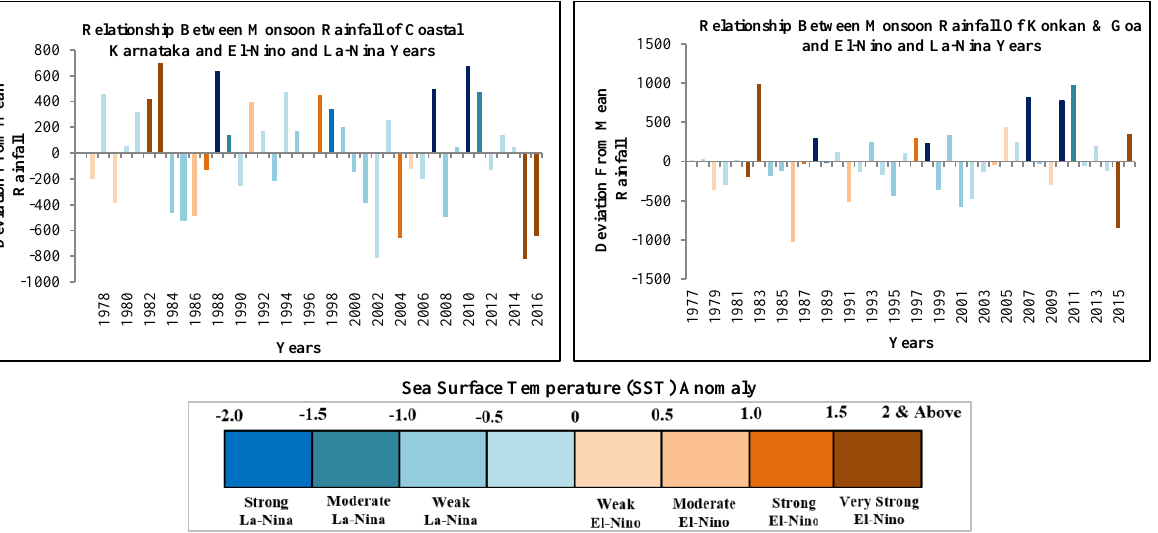
Figure 14. Relationship between Monsoon rainfall and El-Nino and La-Nina